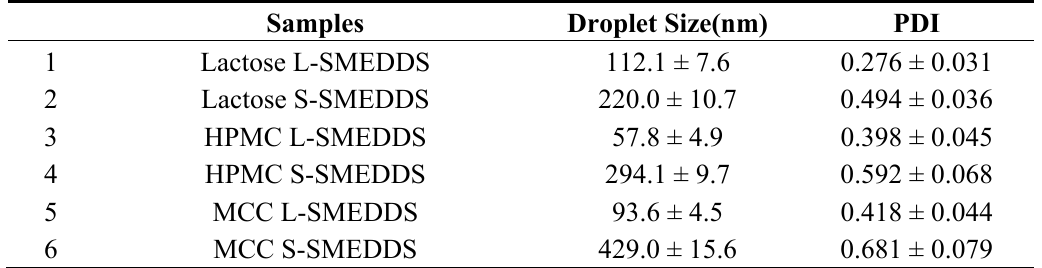
Table 1. Droplet sizes and PDI of liquid and solid SMEDDS using lactose, HPMC and MCC as solid carriers. Results are expressed as mean ± SD of vlaues from triplicate experiments.